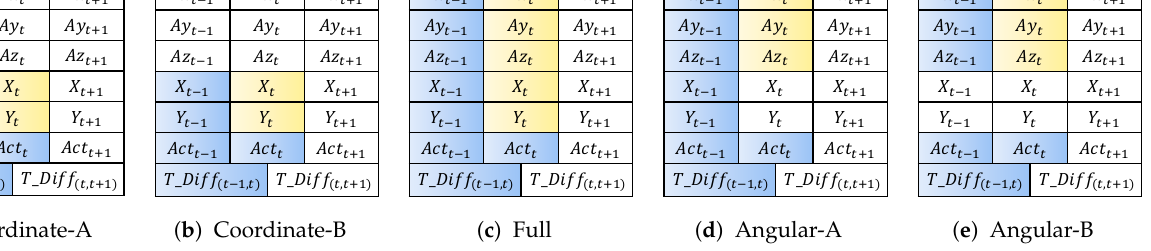
Figure 4. Input and output variables at time t based on five combinations of variable sets for the forward sequence (blue and yellow denote input and output variables, respectively).